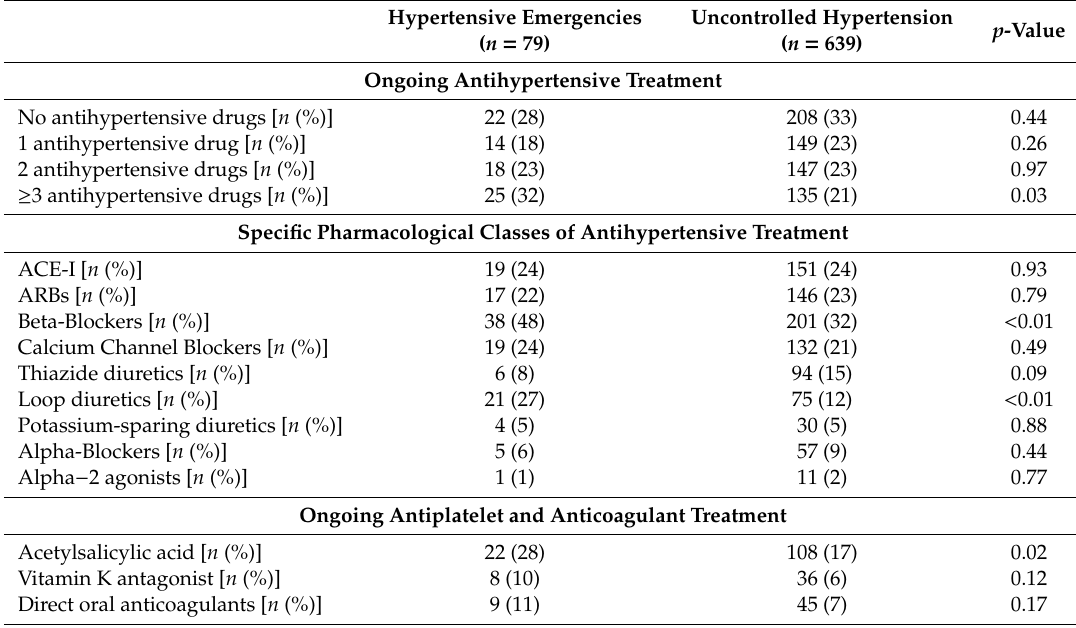
Table 2. Cardiovascular therapy.